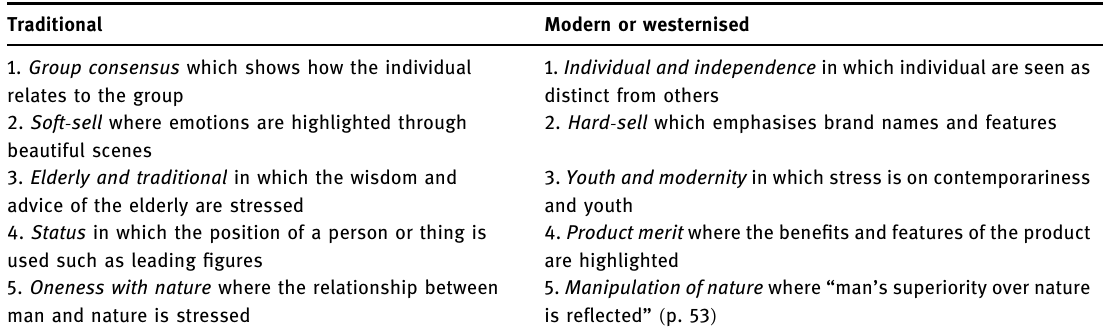
Table 1: Mueller ’ s ( 1987: 52 – 3 ) model of persuasive